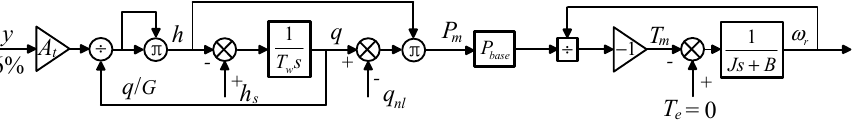
Figure 15. Control diagram of start-up in generating mode.